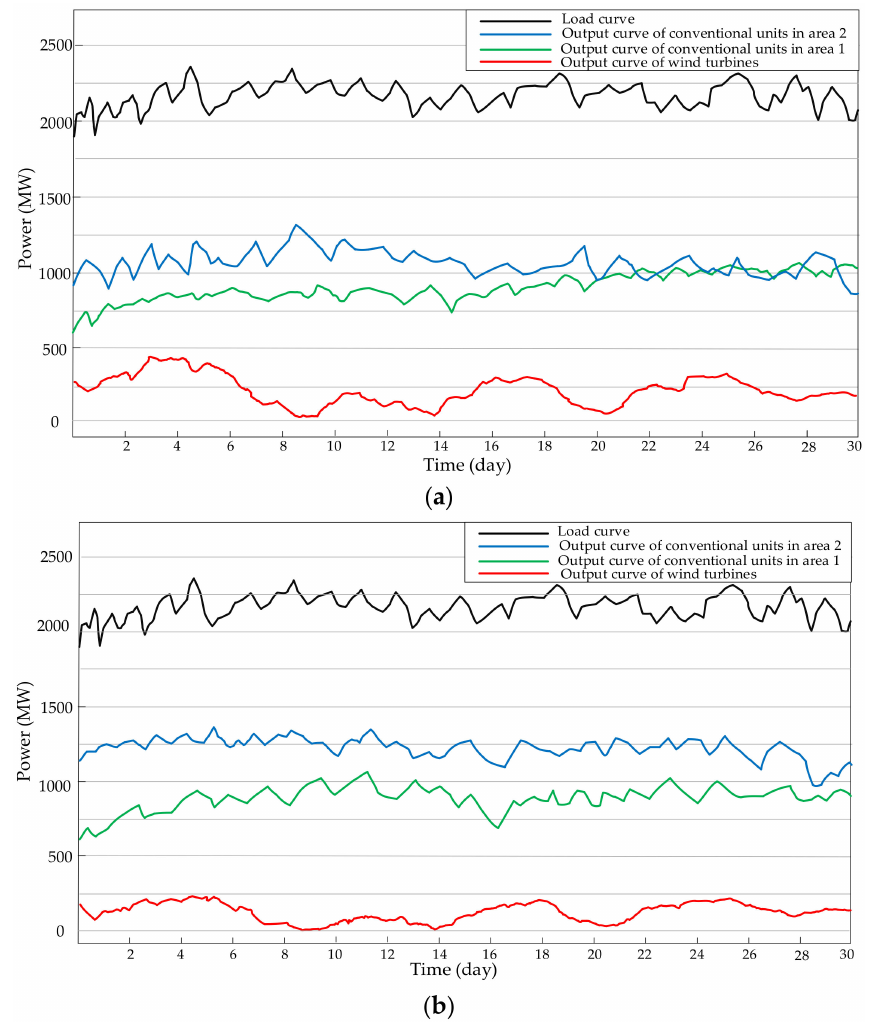
Figure 7. Output of different generation units in two areas with two logics: ( a ) the CPS1&CPS2 logic; ( b ) the BAL-001-2